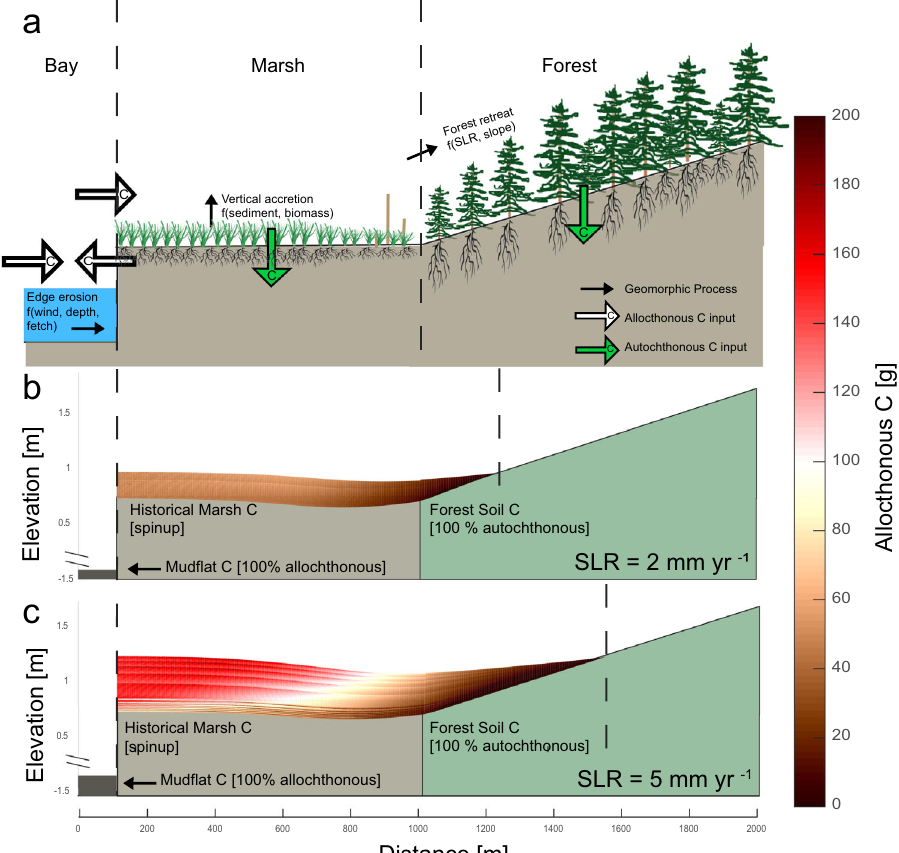
Fig. 1 | Bay-Marsh-Forest transect demonstrates the exchange of carbon between ecosystems and the accumulation of allochthonous carbon in mar- shes. Schematicof2Dtransectmodelofthebay-marsh-forestsystemrepresenting all modeled processes ( a ). Geomorphic processes are indicated with black arrows, while carbon processes are in green (autochthonous, Supplementary Fig. 4) and white(allochthonous,showninpanels b and c ).Thecoastaltransectwassubjected to low [2mmyr − 1 ] ( b ) and moderate [5mmyr − 1 ] ( c ) rates of sea level rise (SLR), which resulted in more allochthonous carbon (C) under high rates of SLR. Model